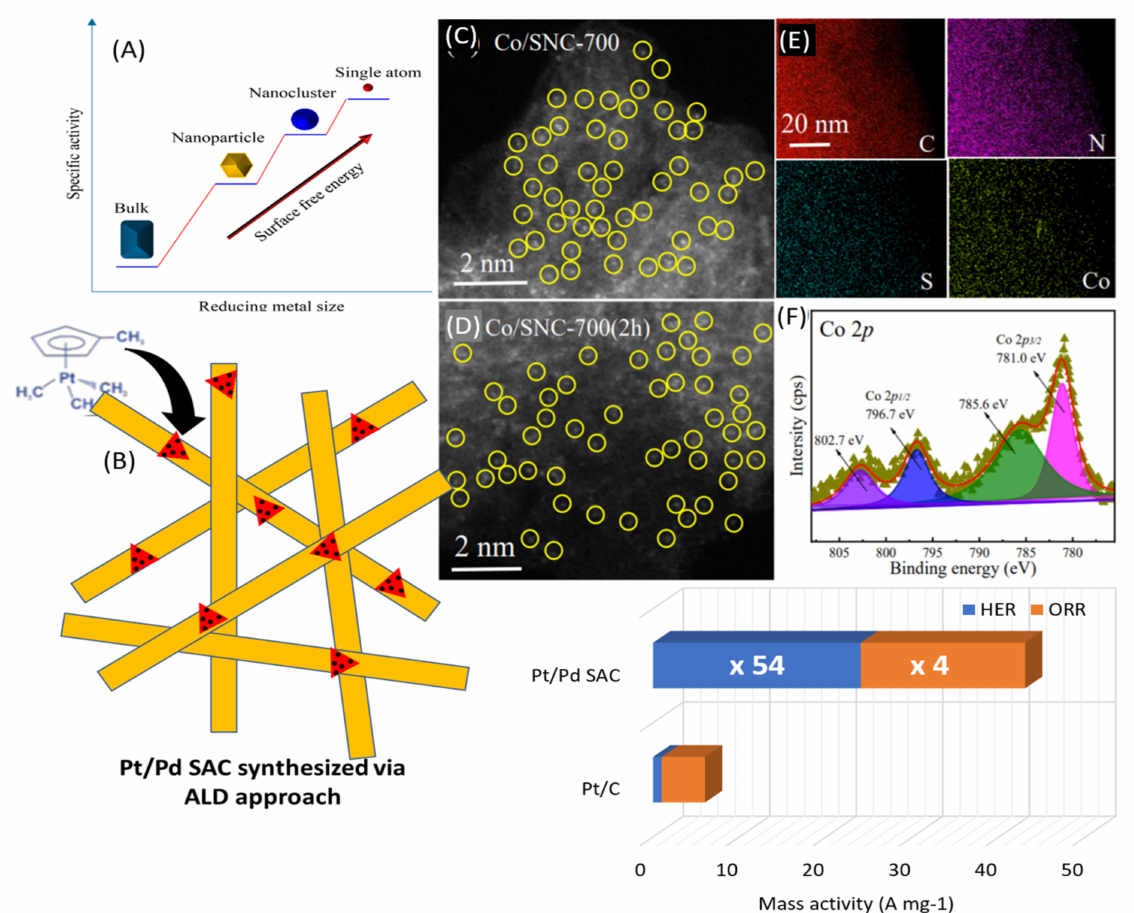
Figure 2. ( A ) The trend transformation of bulk-character NiCo surface free energy to SAC surface free energy. ( B ) Schematic proposed for Pt/Pd alloys structure for HER and ORR reactions. Adapted from [27], ( C , D ) the HAADF-STEM images for Co/SNC and Co/SNC after calcination at 2 h, ( E ) elemental composition of Co/SNC using EDX mapping, and ( F ) XPS pattern for Co/SNC. Adapted with permission from